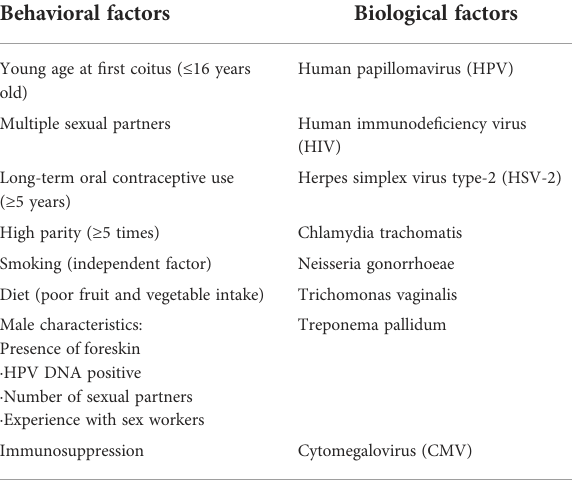
TABLE 1 Factors linked to the development of cervical cancer.